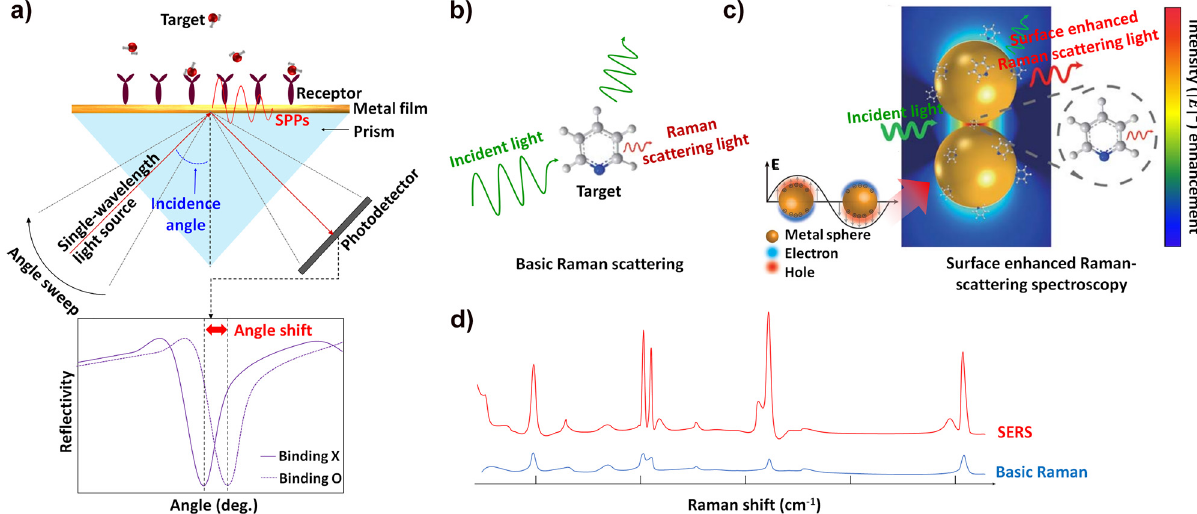
Figure 16: Two representative types of plasmonic spectroscopy. (a) General setup of SPR spectroscopy. The SPR spectroscopy measures the reflected light intensity depending on the angles affected by